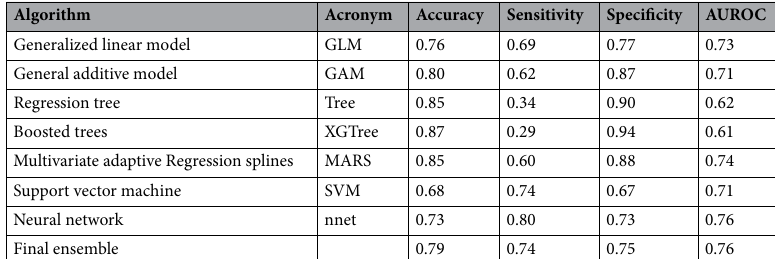
Table 3. Final model performance.